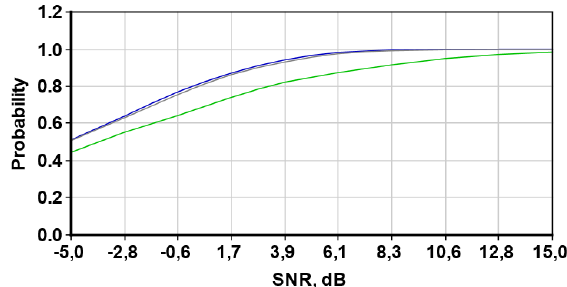
Fig. 3. The relation between probability of determining the bearing with an error less than threshold of 0.2 degrees and